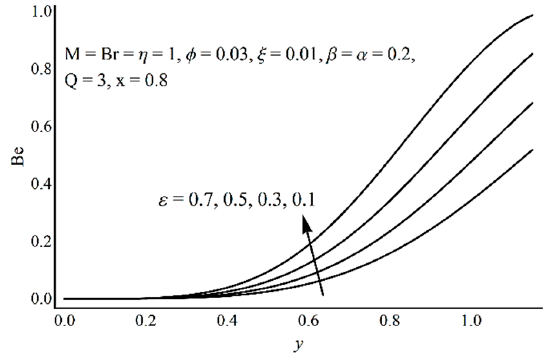
Figure 18. The Bejan number against various ε values.